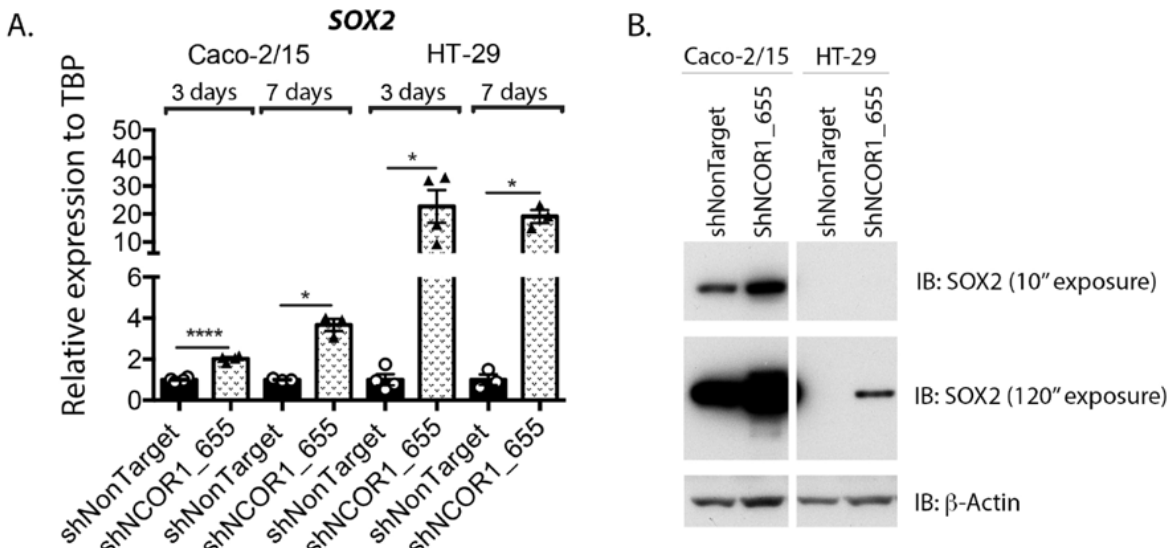
Figure 9. NCOR1 downregulation increases SOX2 expression in CRC cells. ( A ) Total RNA was isolated at 3 and 7 days following lentiviral infection of Caco-2/15 and HT-29 cells with shNonTarget or shNCOR1_655 constructs. SOX2 expression relative to TBP was measured by qRT-PCR ( n = 3–4; means ± SEM). Student’s t -tests were used to measure the significance of the results (* p < 0.05; **** p < 0.0001). ( B ) Immunoblots were performed to detect SOX2 protein expression. Total protein extract was isolated at 7 days following lentiviral infection of Caco-2/15 and HT-29 cells with shNonTarget, shNCOR1_655, or shNCOR1_656 constructs. The relative level of β -actin protein was monitored to control protein loading ( n = 3).